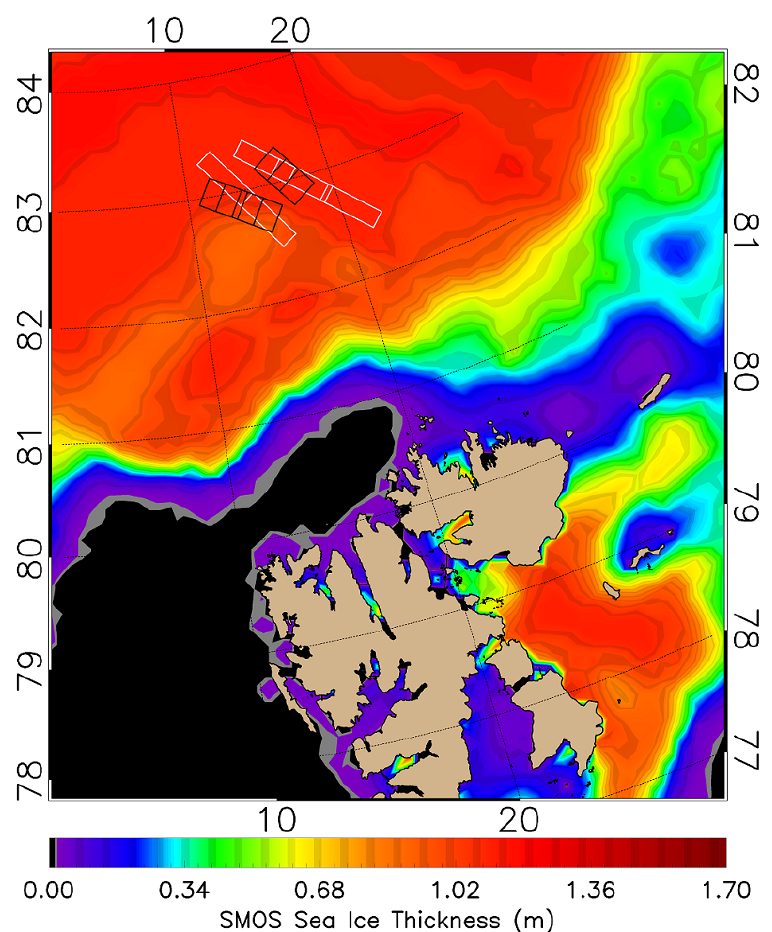
Figure 1. Sea ice thickness on 15 April 2015 according to L3C SMOS data provided by ZMAW, Hamburg). Rectangles indicate the footprint of the acquisitions. The left image cluster was acquired on 19 April 2015 with temporal distance of 94 min, the right image cluster was acquired on 23 April 2015 with temporal distance of 59 min. The slim, long acquisitions are TS-X image (shown in white rectangles), the wider shorter ones are RS-2 images (shown in black